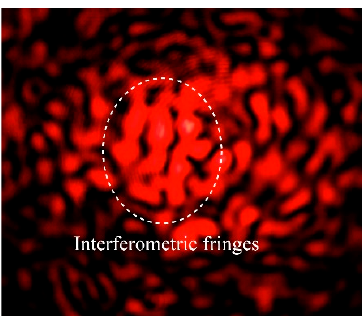
Figure 3. Interferogram captured by a COMS camera at the output end of the DCF. Air pressure in the air channel of the DCF is changed from ~100.0 hPa to atmosphere pressure (~1018.0 hPa). (Video S1 in Supplementary).